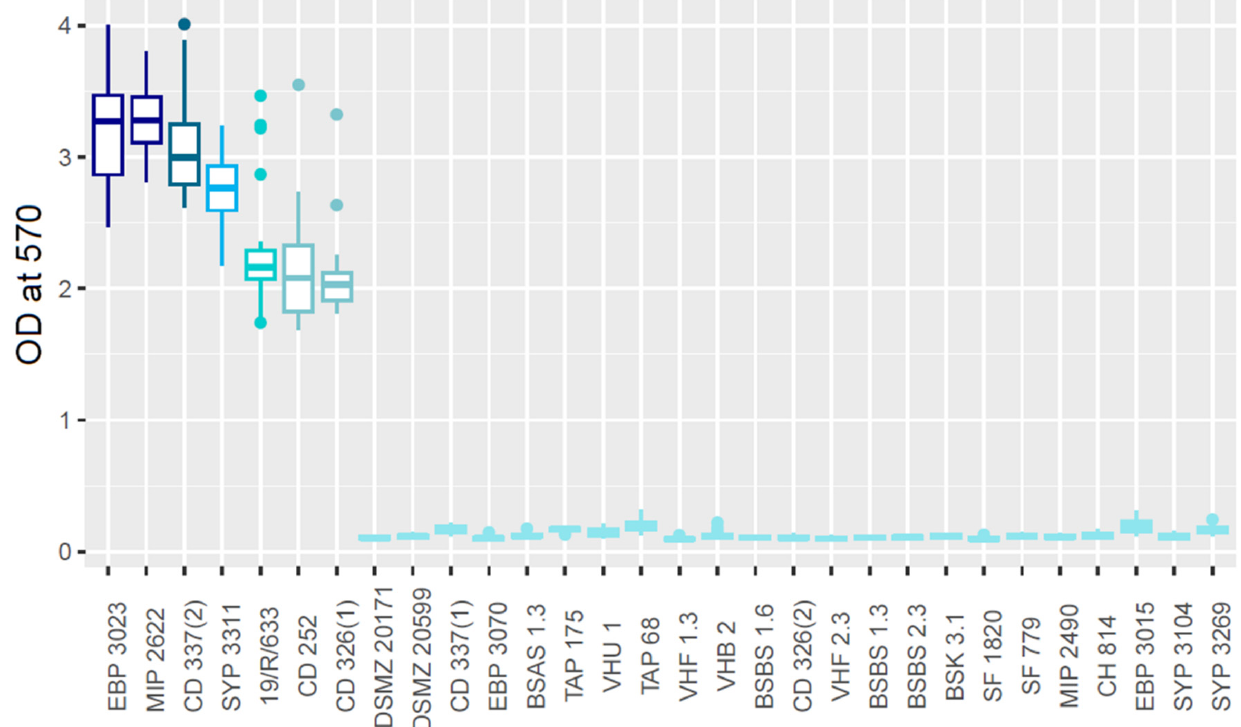
Figure 1. Strain distribution following cBRT clustering and size of each cluster (cluster; number of strains; %). A total of 19 strains were classified as poor early biofilm producers, representing 63% of our strains sample. A total of 4 strains as weak early biofilm producers (13%). A total of 5 as moderate early biofilm producers (17%). A total of 2 as high early biofilm producer (7%).